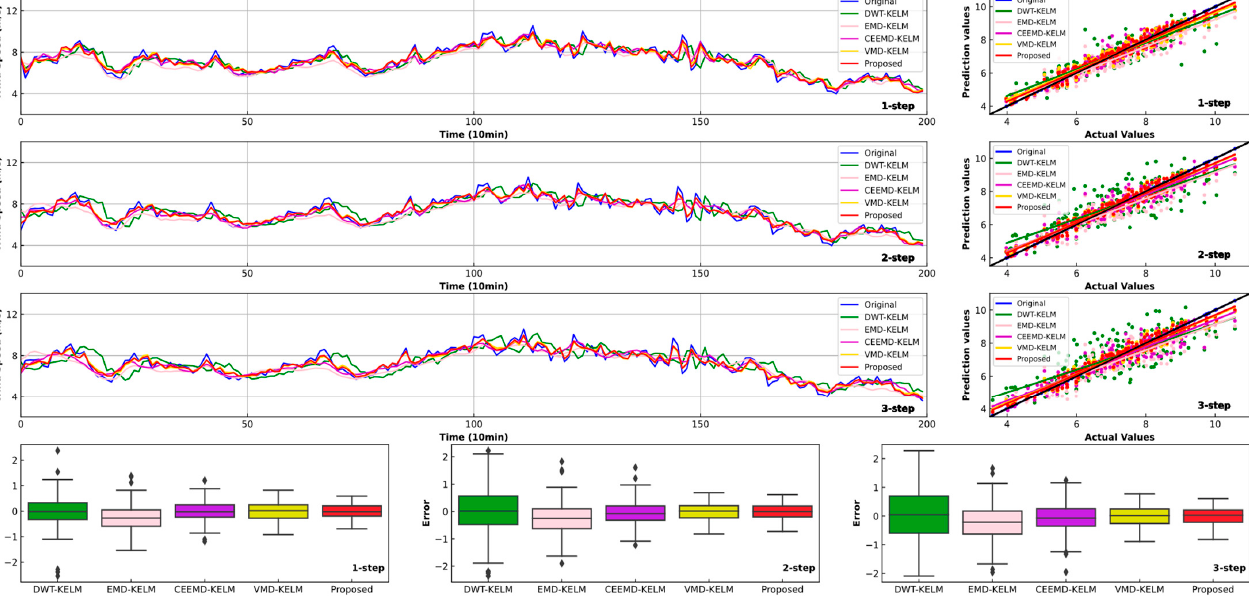
Figure 7. Forecasting performance of decomposed models in one, two and three-step ahead forecasting for the autumn dataset.